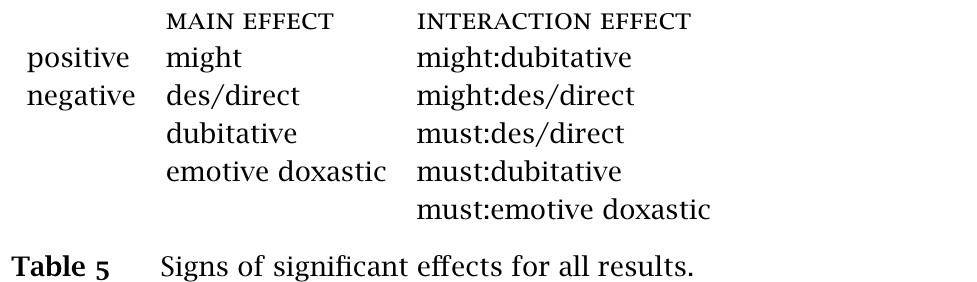
Signs of significant effects for all